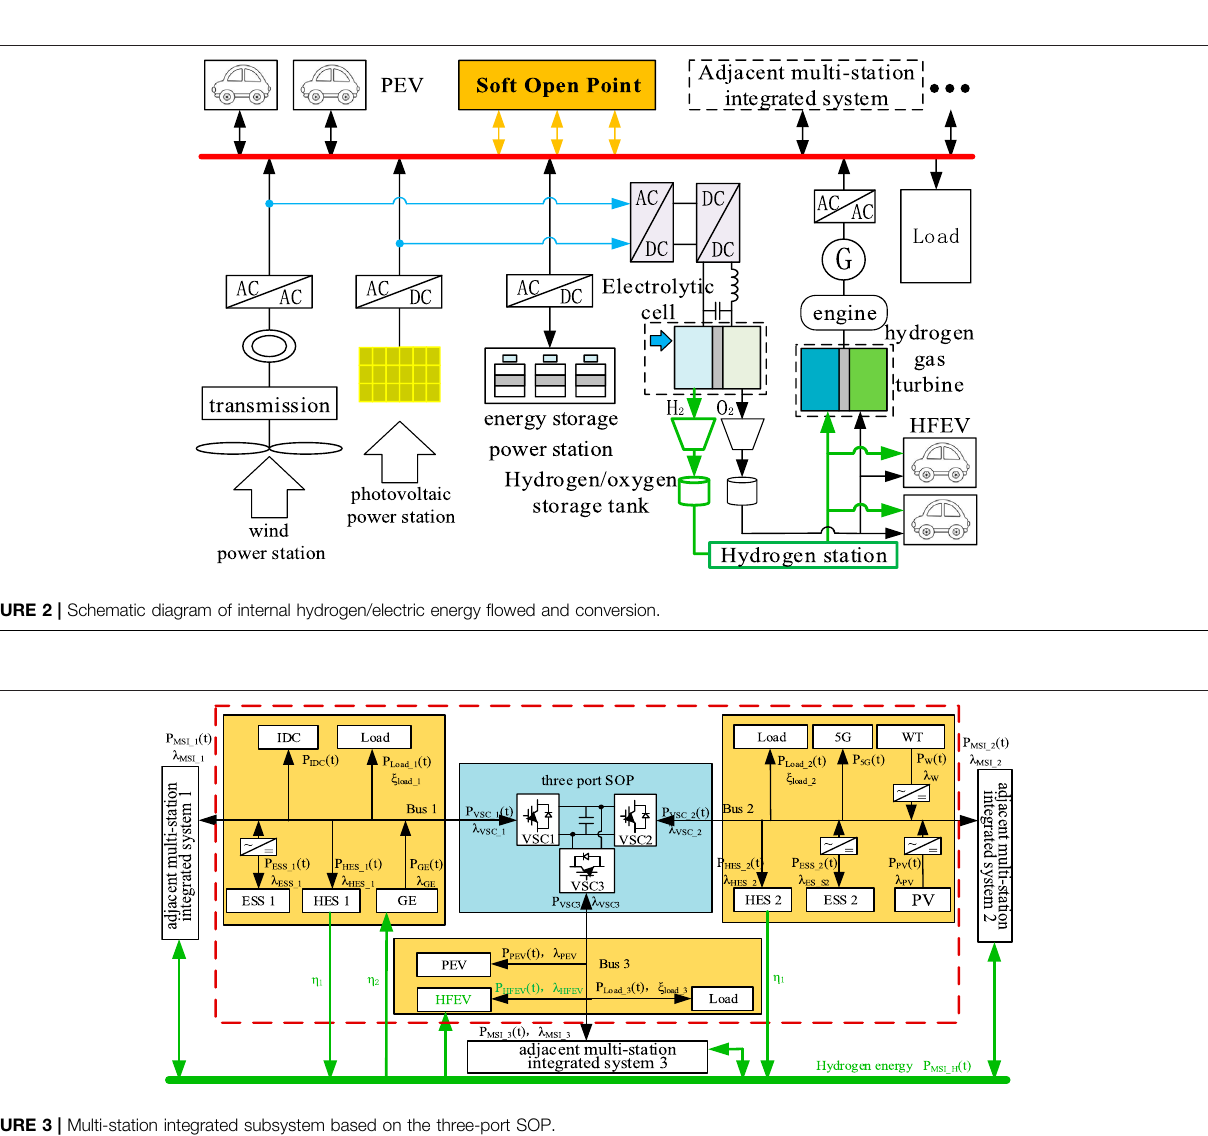
FIGURE 3 | Multi-station integrated subsystem based on the three-port SOP.